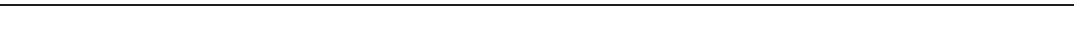
Fig. 4 Upon stress Rbfox1 aggregates in higher-order subcellular structures in ovaries. a , b Upon prolonged protein starvation (1 – 3 weeks) in Control ( a ) and miR-980 ( b ) ovaries, Rbfox1 aggregates in cytoplasmic and nuclear droplets of various size and shape. c , d Sometimes, Rbfox1 can form various phase- separated long fi bers in both germline ( c lower panel) and somatic follicle cells ( d ) of miR-980 mutants. e Similar higher order structures can be found in starved mitochondrial stress-linked parkin mutant ovaries. f , g Rbfox1-positive fi bers ( f ) and round granules ( g ) formed in starved ovaries co-stain with Thio fl avin T, a benzothiazole dye that exhibits enhanced fl uorescence upon binding to amyloid fi brils. h – j FRAP experiments performed on ovaries of fl ies with GFP-tagged Rbfox1 protein ( Rbfox1 CC00511 /TM3 ). h Images of germline cell at different time points; prebleached ( − 1 s), postbleached (0 s), and after recovery (7 s). White box (ROI1) outlines an Rbfox1-positive granule subjected to photobleaching, yellow box (ROI2) outlines an Rbfox1-positive granule not subjected to photobleaching, and blue box (ROI3) outlines a background area that was not subjected to photobleaching ( n > 50 measurments for each ROI). i Scatter plot for correlation analysis between the initial intensity, bleaching ef fi ciency, mobile fraction, and recovery half-time parameters. j Fitted plots of the FRAP recovery curves show two distinct groups of Rbfox1-positive droplets that differ in their recovery half-times. Note that for FRAP experiments, due to lethality, heterozygous animals that have only one copy of GFP-tagged Rbfox1 protein were used ( Rbfox1 CC00511 /TM3 ). This means that only half of the Rbfox1 proteins could be subjected to photobleaching and that non-labelled Rbfox1 proteins would also participate in liquid droplet recovery. Thus, the half-time of fl uorescence recovery estimated here is most likely two times slower than the actual recovery half-time. DAPI (nuclei, magenta, a – e ); Thio fl avin T (amyloid, magenta, f , g ); Rbfox1 (green, a – g ). White rectangle in f , g outlines the area presented as separate panels (right), arrows point to Rbfox1-positive subcellular aggregates. a , b — ovarioles; c , f , g — egg chamber showing germline and somatic cells with large and small nuclei, respectively; d , e — follicular epithelial cells. Images in a – e are maximum intensity projections of multiple Z-sections, and images in f – h are single Z-sections. Scale bars 5 µ